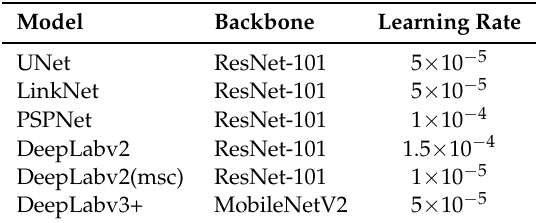
Table 2. Training details for each model.